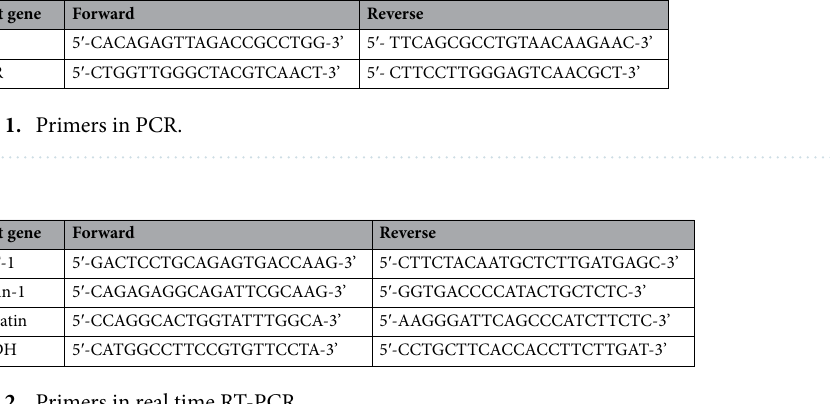
Table 2. Primers in real time